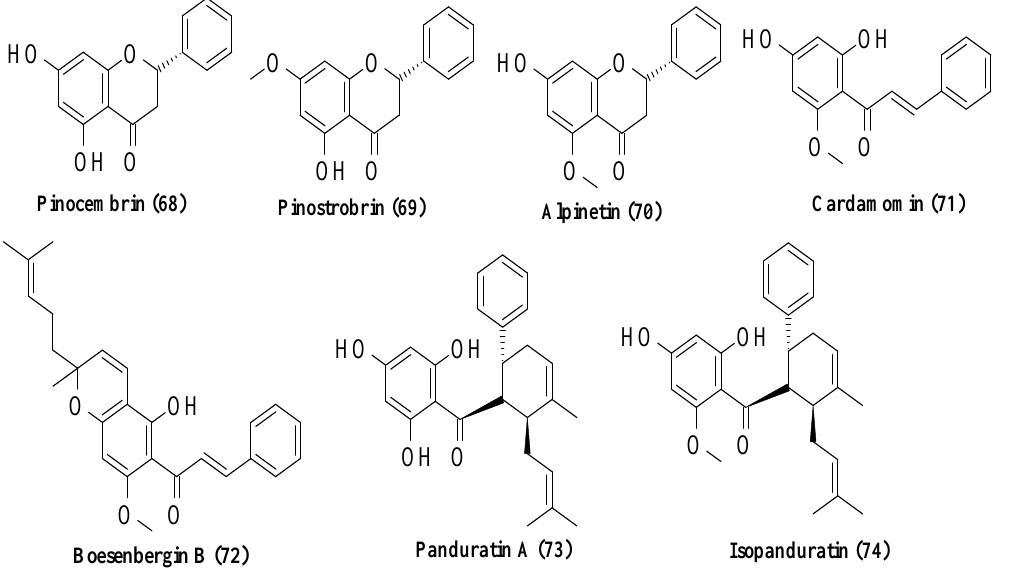
Figure 20. The structures of flavonoids isolated from B. rotunda [57].